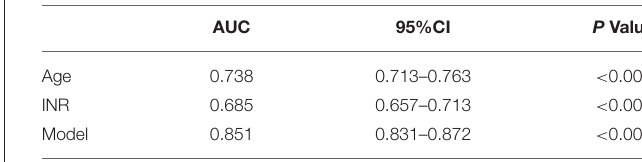
TABLE 5 | Predictive effects of different indicators on